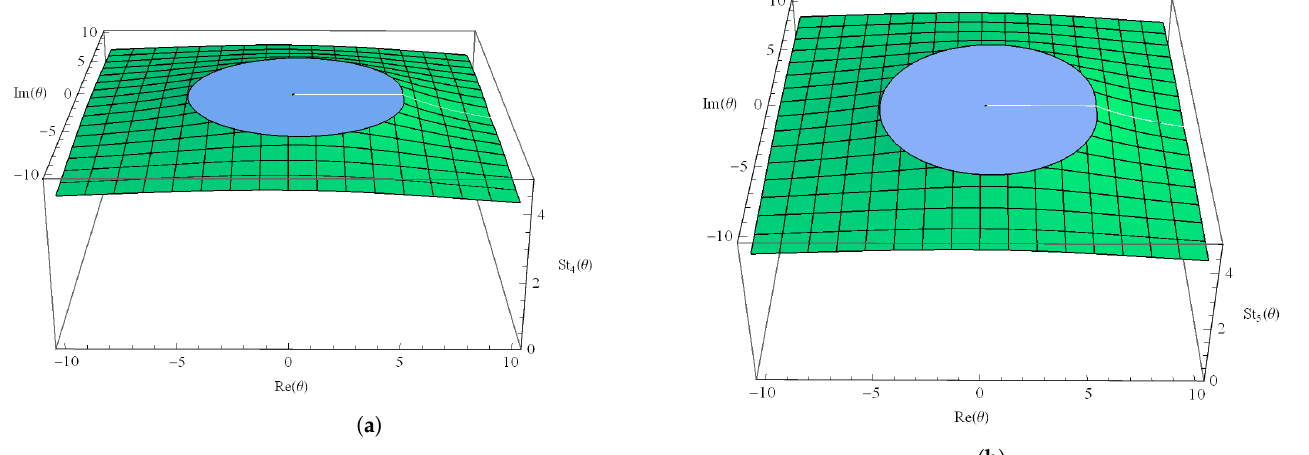
Figure 4. Stability functions. ( a ) Stability function for exf 3 ( θ ) , ( b ) Stability function for exf 4 ( θ )